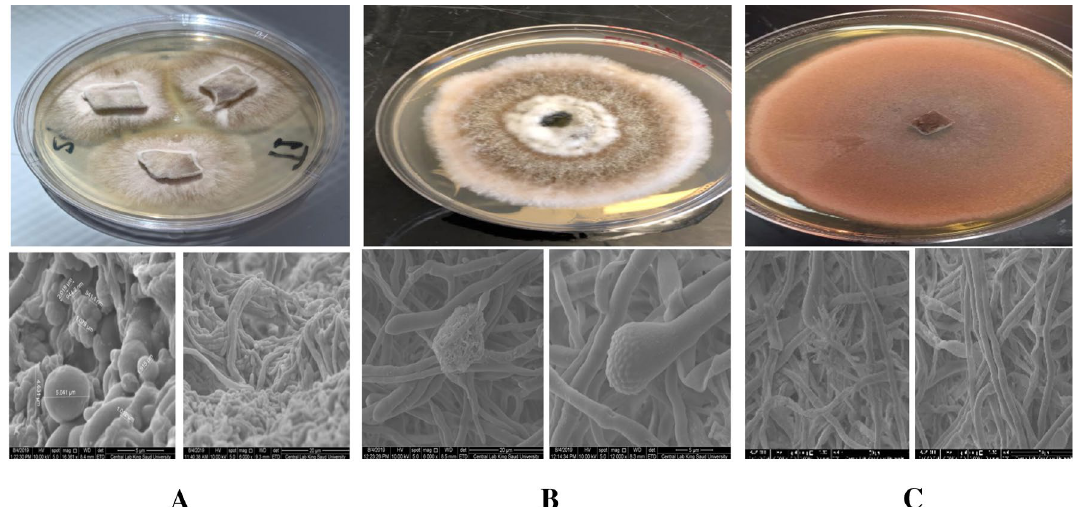
Figure 2. The colony characteristics in PDA plates and under SEM of the three endophytic fungi Chaetomium sp ( A ), Bipolaris sp. ( B ) and Fusarium venenatum ( C ) isolated from Tabuk, AlQasab and Almuzahimiyah,